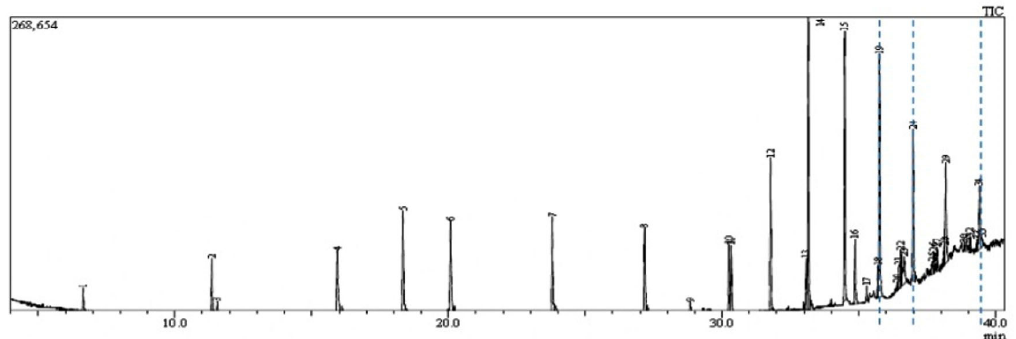
(Retention time) of 36.65 t of 37.47 min and Spiro [Cyclopentane-1,2'(1'H)- t